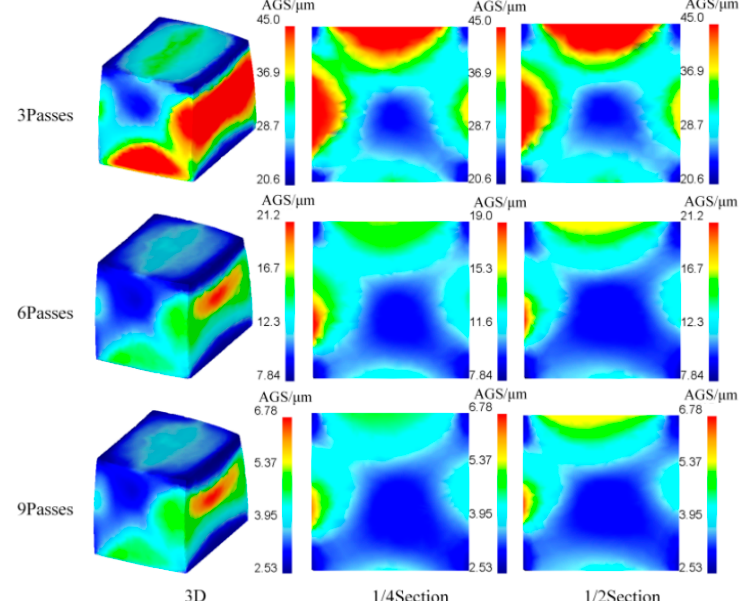
Figure 17. Recrystallization grain size cloud image of forging from three to nine passes at 1000 °C.